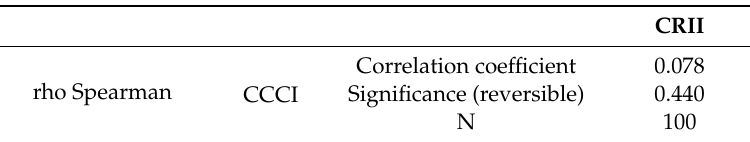
Table 31. Correlation between CCCI and